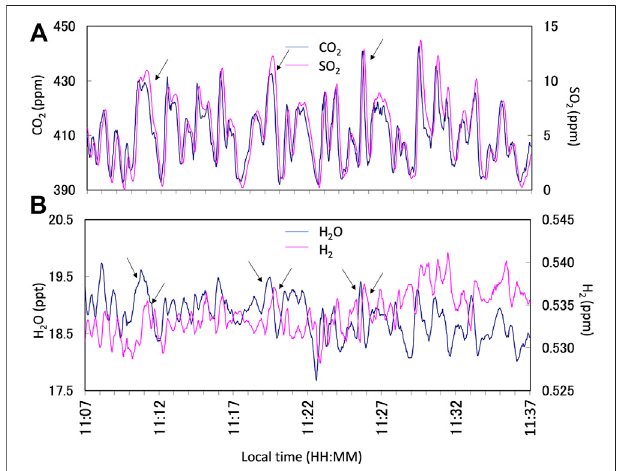
FIGURE2| ExampleoftheMulti-GASobservationresultson13January 2018. (A) Time series of CO 2 (blue line) and SO 2 (pink line) concentrations in parts per millions (ppm). (B) Time series of H 2 O (blue line) and H 2 (pink line) concentrations in parts per thousands (ppt) and ppm, respectively. The arrows indicate the corresponding plume signals for the analyses. Note that the response of the H 2 signal is slow because the sensor is semi-conductor based. All data are fi ltered by a 15-s running average to reduce the instrumental noises. Notice that the correlation analyses were made using Ratiocalc